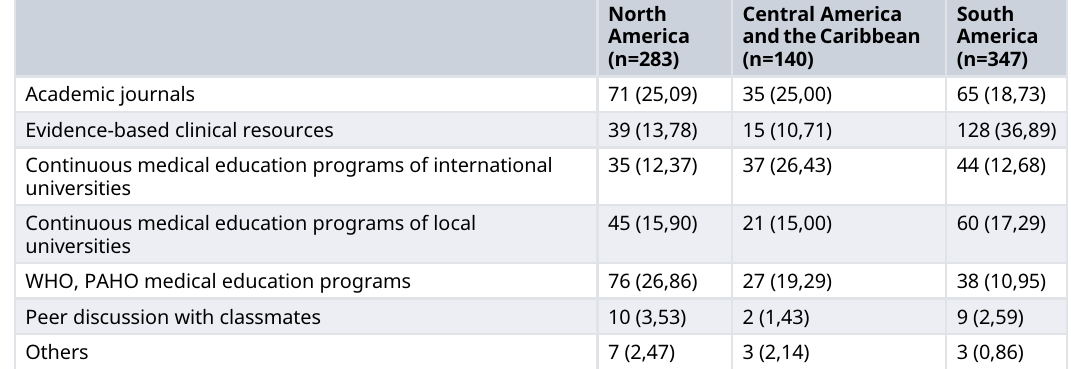
Table 2. Sources for COVID-19 training amongst medical students in Latin